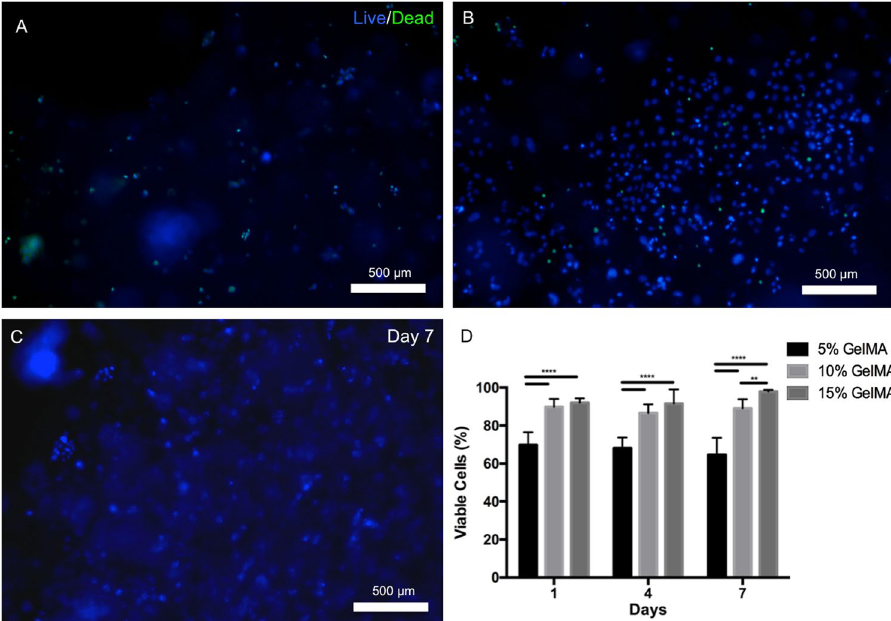
Figure 3. Viability of OD21 cells in GelMA hydrogel scaffolds. Representative images of OD21 cells encapsulated in ( A ) 5%, ( B ) 10% and ( C ) 15% GelMA hydrogels stained for live (blue) and dead (green) cells on day 7. ( D ) Percentage of live cells in the hydrogels after 1, 4 and 7 days showed consistently enhanced OD21 cell survival in 10 and 15% GelMA hydrogels compared to the softer 5% GelMA hydrogels at all time points, with a statistically significant increase in cell viability in 15% GelMA hydrogels over 10% GelMA hydrogels by day 7. Statistical significance is represented by ** for p < 0.01 and **** for p <